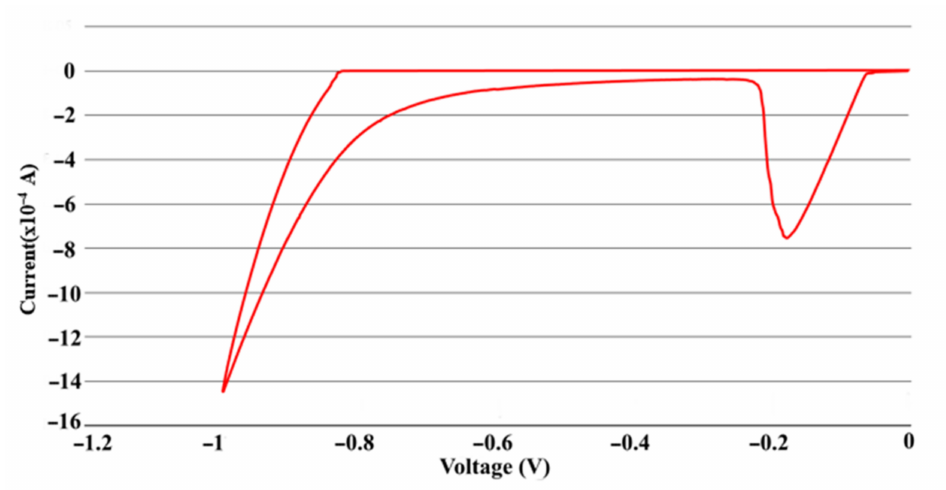
Figure 1. CV measurements on 0 to − 1 V to acquire the reduced voltage of